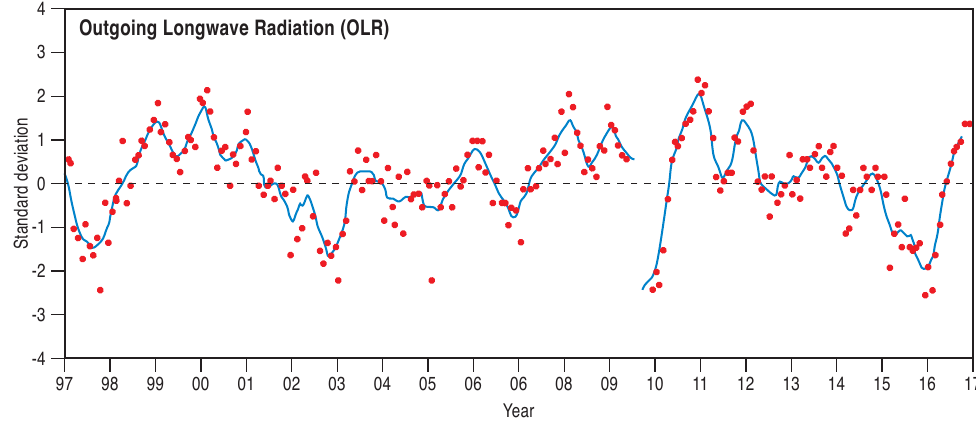
Figure 3. Time series of outgoing longwave radiation (see Table 2), 1997–2016, showing clearly the below average OLR for the 1997–1998 and 2015–2016 El Niño events. Sourced and redrawn from the Climate Diagnostics Bulletin http://www.cpc.ncep.noaa.gov/products/CDB.